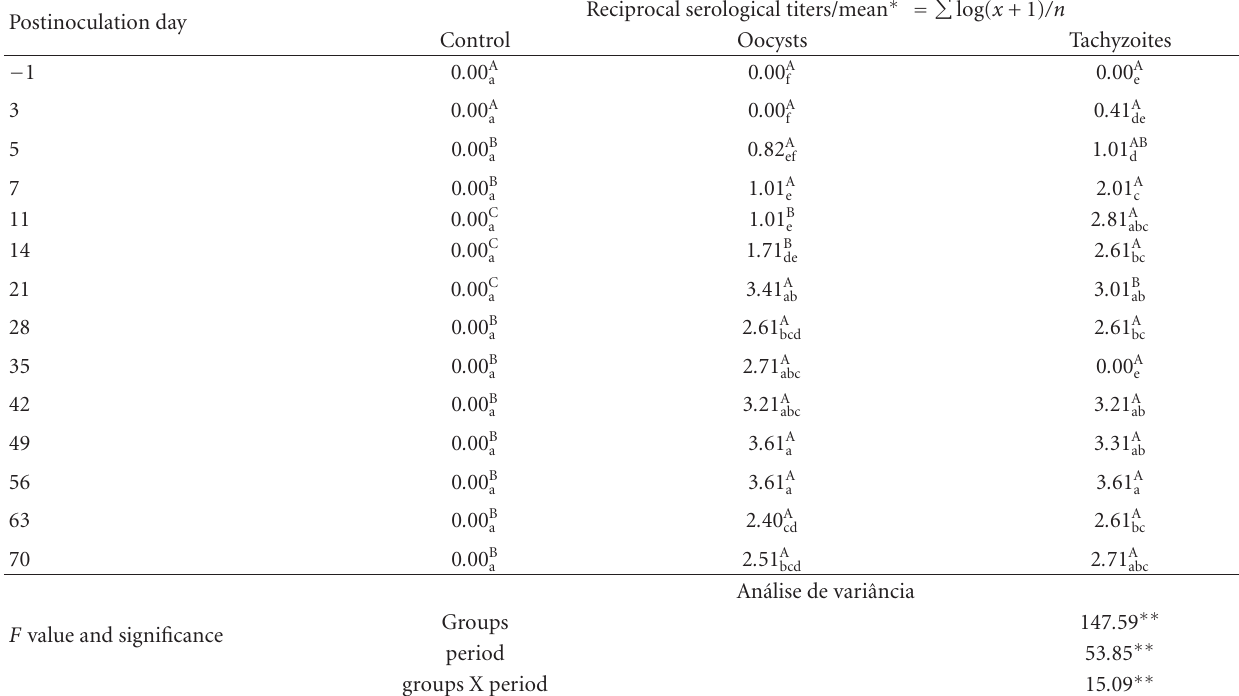
Table 2: Results of multiple comparisons and analysis of variance of the serological titers of noninoculated (control) and T. gondii oocyst- inoculated (2 . 0 × 10 5 ) or tachyzoite-inoculated (1 . 0 × 10 6 )